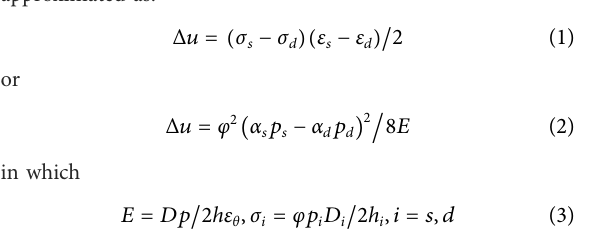
Figure 2 is the linear strain energy density. The SEDI ( Δ u ) between the systolic and diastolic periods can be approximated as: